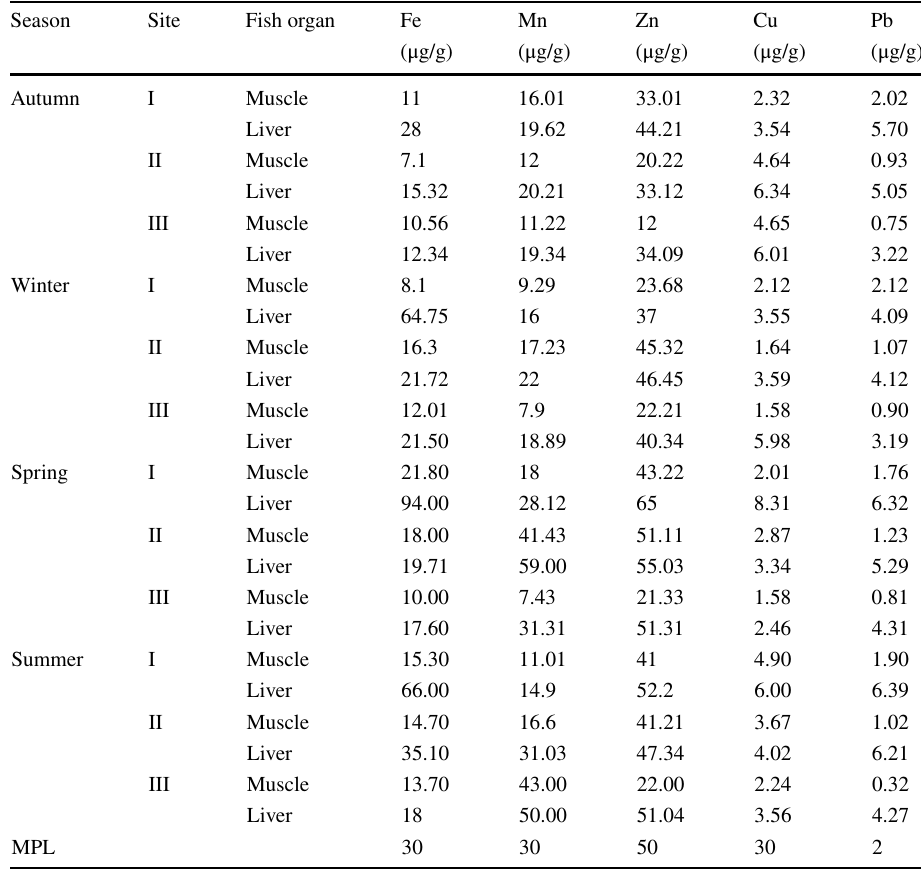
concentration in fish muscles and liver (μg/g dry wt) from autumn 2018 to summer 2019 at sites I, II,